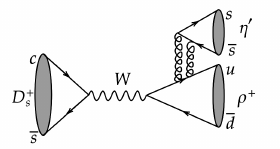
Figure 1 . The T P -diagram (left), A V -diagram (middle) and A P -diagram (right) for D + The subscript P ( V ) implies a pseudoscalar (vector) meson.